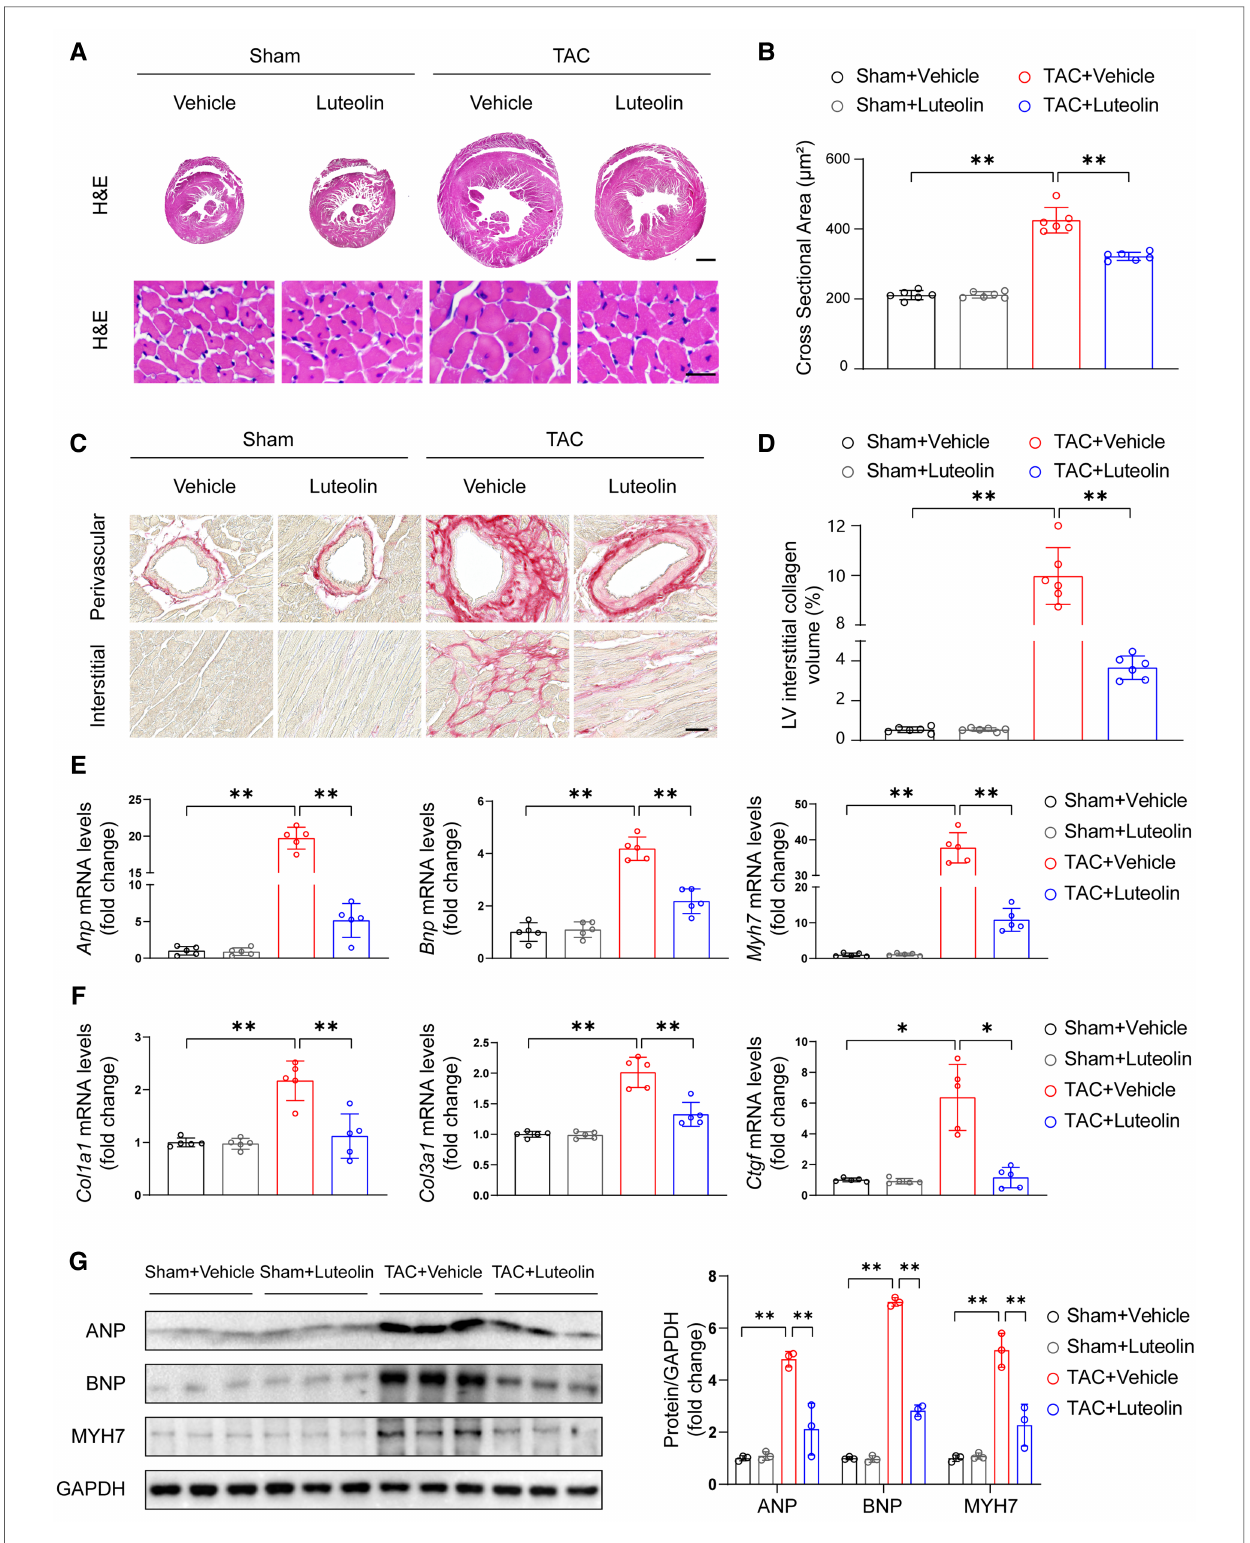
FIGURE 4 Luteolin prevents cardiac hypertrophy and fi brosis in mice. ( A ) Representative images of hematoxylin-eosin (H&E) staining of left ventricular cross- sections in the mice hearts at 12 weeks after sham or TAC surgery ( n =6). Scale bar, 1 mm for the top set and 25 μ m for the bottom parts. ( B ) Quantitative results of average cross-sectional areas from the indicated groups. ( C ) Representative images of picrosirius red (PSR) staining of left ventricular cross-sections in the mice hearts at 12 weeks after sham or TAC surgery ( n =6). Scale bar, 50 μ m. ( D ) Quantitative results of left ventricular interstitial collagen volume from the indicated groups. ( E,F ) Relative mRNA levels of hypertrophy and fi brosis marker genes in heart tissues from the indicated mice ( n =5). ( G ) Immunoblotting (left) and quantitation (right) of ANP, BNP, and MYH7 protein levels in the mice hearts at 12 weeks after sham or TAC surgery ( n =3). Values are presented as mean±SD. * P <0.05, ** P <0.01. ANP , atrial natriuretic peptide; BNP, b-type natriuretic peptide; PE, phenylephrine; MYH7, myosin heavy chain